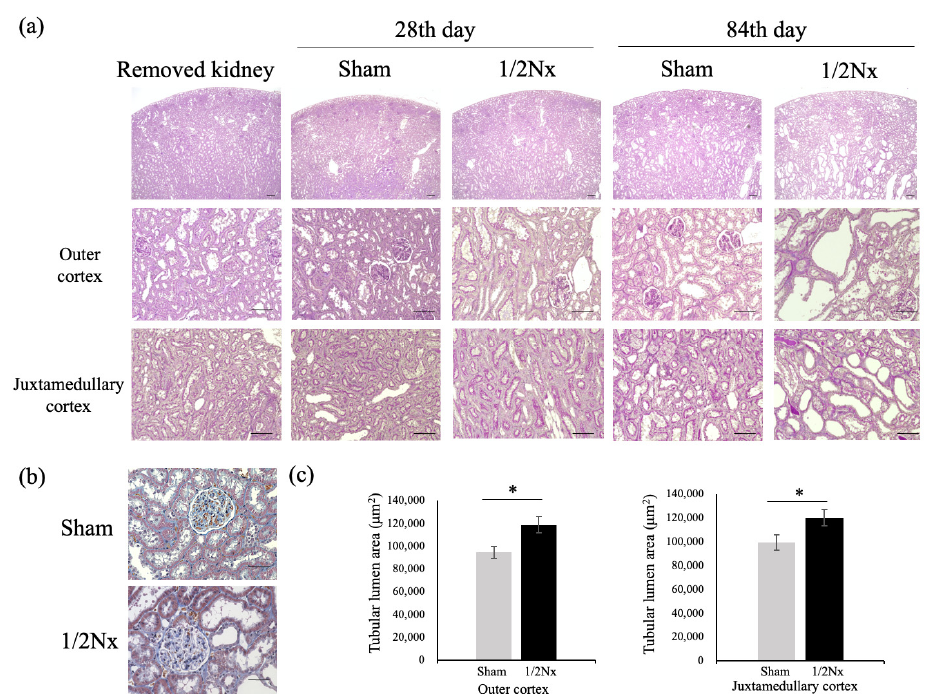
Figure 5. Histological analysis of kidney after surgery. Histological analysis of renal tissues from Sham operated and 1/2Nx rats on the day of operation (removed kidney) and 28 and 84 days after surgery. ( a ) PAS staining showing renal tubular dilation in cortices. The top panels show images at low magnification (scale bar = 200 μ m), whereas the middle and bottom panels show images at high magnification of the outer and juxtamedullary cortices, respectively (scale bar = 50 μ m). ( b ) MT staining showing glomerulus structures 84 days after surgery (scale bar = 20 μ m). Mild fibrosis was observed in 1/2Nx glomeruli. ( c ) Areas of tubular lumen in Sham operated and 1/2Nx rats 84 days after the operation. MT staining; scale bar = 50 μ m. n = 3 with at least three randomly selected sections in each area analyzed in each group. * p < 0.05 between-group differences.